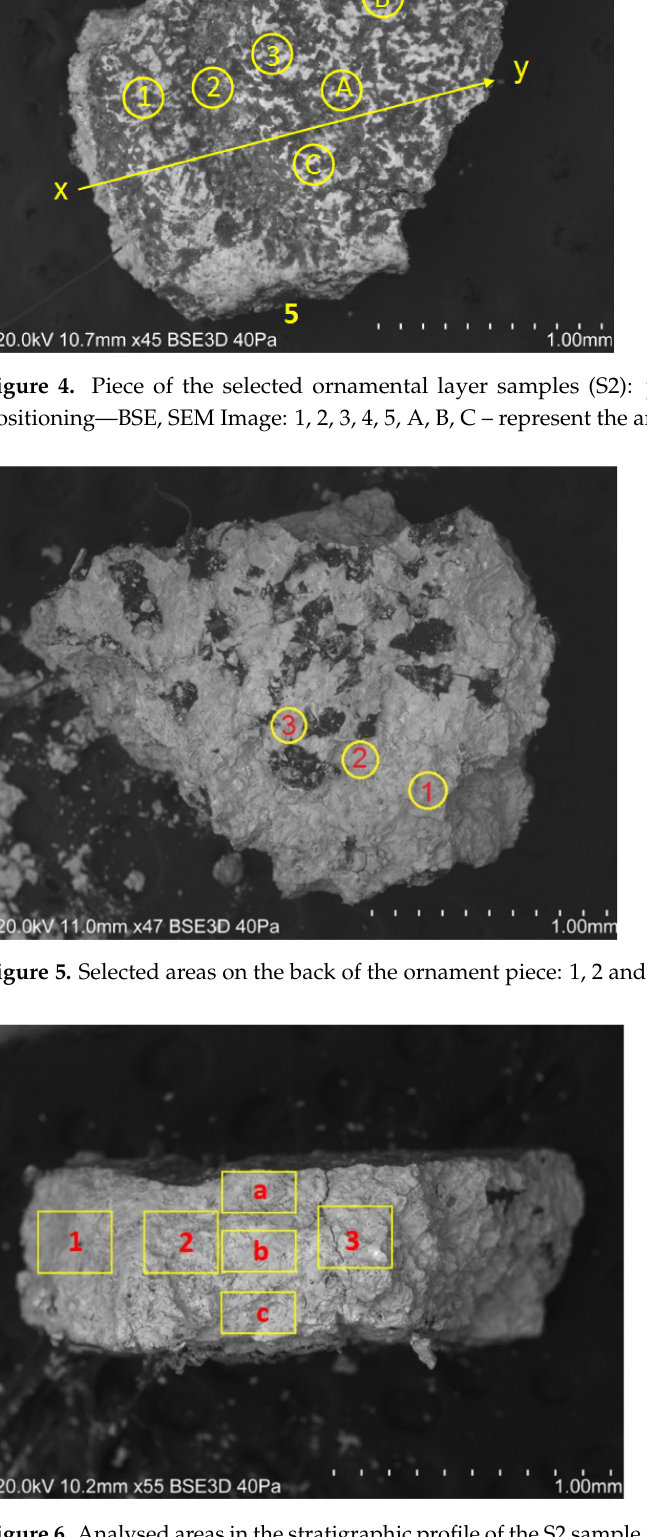
Figure 6. Analysed areas in the stratigraphic profile of the S2 sample, after cutting on the x-y direction: 1, 2, 3 on orizontal and a, b, c on vertical